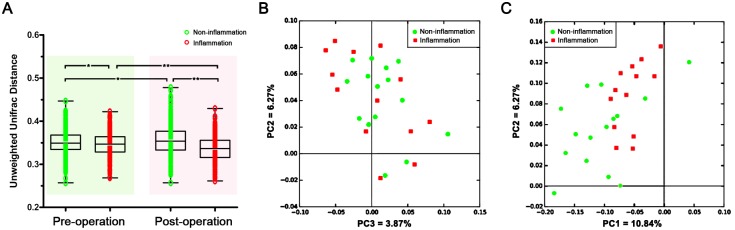
Beta diversity of the oral microbiome of non-inflammation and inflammation groups based on the unweighted UniFrac metric.(A) The inflammation samples were significantly more similar to one another than the non-inflammation samples both in the pre- and post-operative comparison. Principal coordinate analysis (PCoA) plot shows clustering of most inflammation samples, which were separated from non-inflammation samples (B) before and (C) after the operation. Red and green dots indicate inflammation and non-inflammation samples, respectively. * 0.01 < P < 0.05, ** P < 0.01.